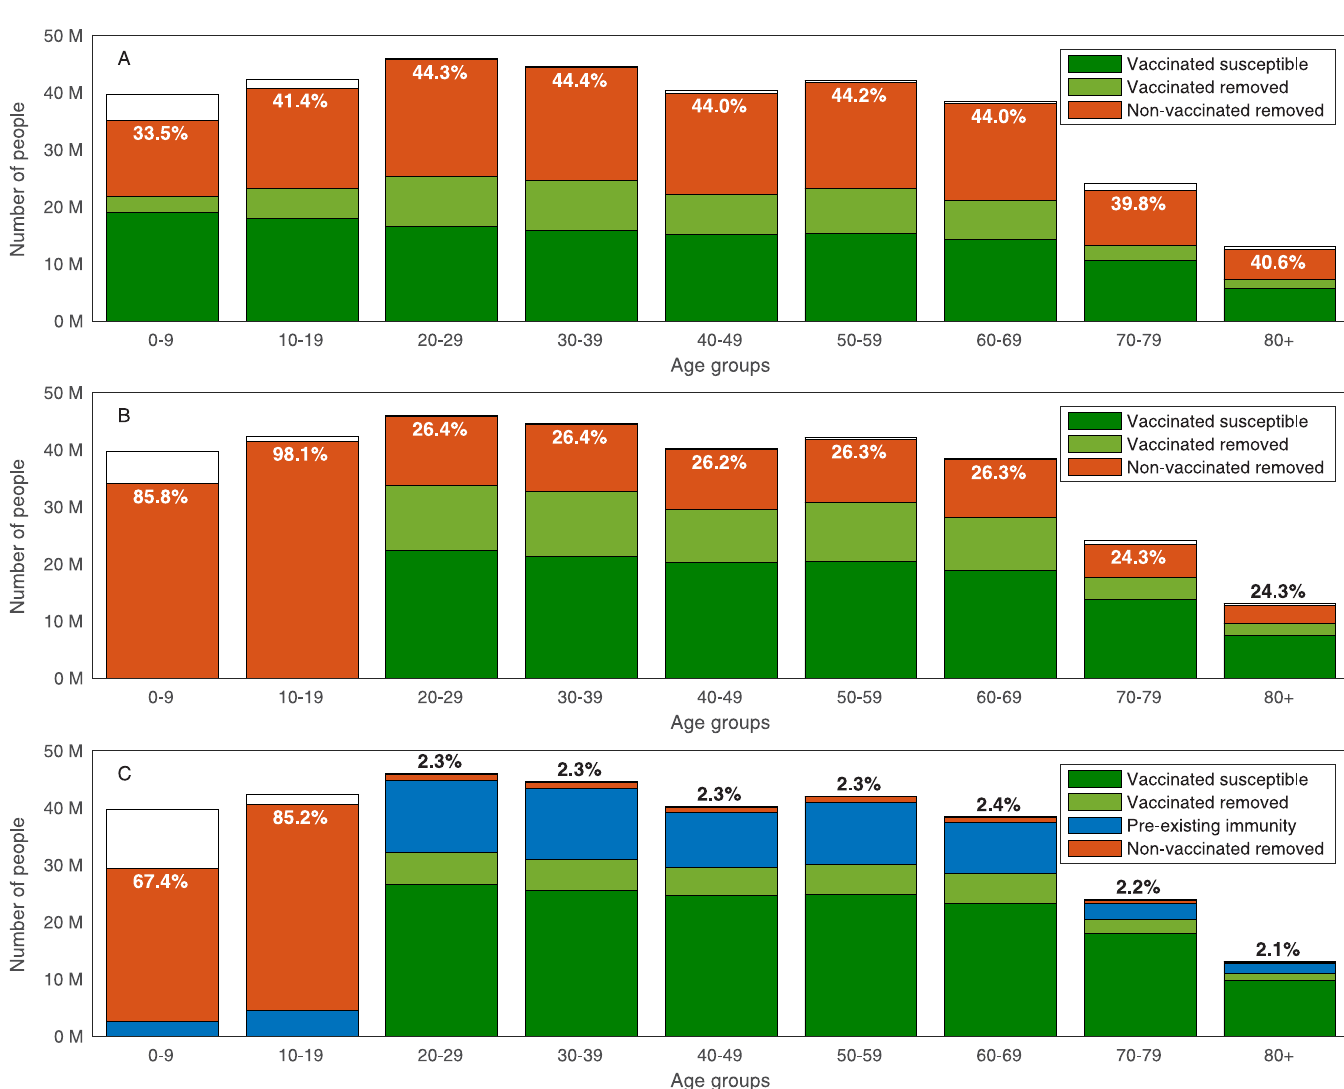
Fig 1. Final size of the epidemic. Final size of an epidemic spreading with basic reproduction number of R 0 = 6 after 55% of the population of the USA is vaccinated with no age prioritization. Removed population refers to those recovered or dead. The computation considers a vaccination campaign in which A: Vaccines are allocated to all ages. B: Vaccine allocation is limited to ages 20 and above. C: Vaccine allocation is limited to ages 20 and above, 20% of the population has preexisting immunity recovered from COVID-19, and the prevalence of active cases is 0.5% of the population. The text in all graphs corresponds to the percent of non-vaccinated removed individuals in each age